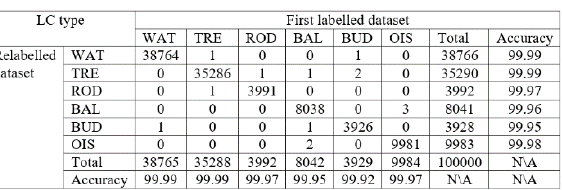
Table 3. Hyperparameters involved in the designed CNNs. Table 4. Confusion matrix of labelled dataset.